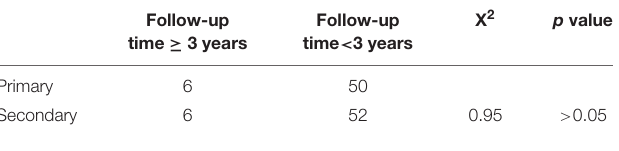
TABLE 4 | Cost composition of a single detection of urine